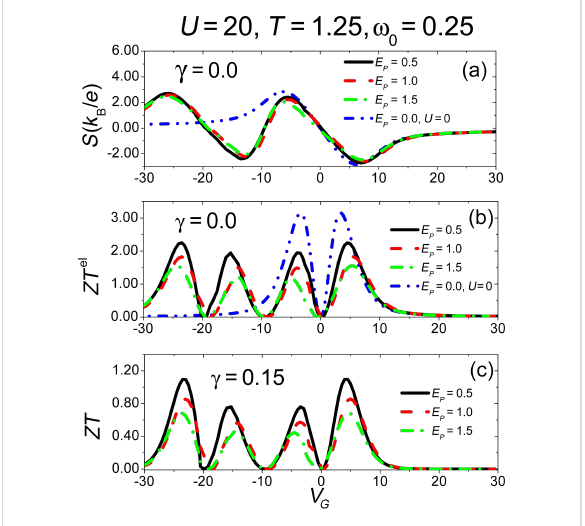
Figure 8: Thermal transport properties in the linear response regime, within the range of validity of the adiabatic approximation and includ- ing the electron–electron interaction. Panel (a): Seebeck coefficient S in units of k B / e for different values of electron–vibration coupling E P (in units of ). Panel (b): Dimensionless thermoelectric figure of merit ZT el for the electronic system only. Panel (c) shows the total thermo- electric figure of merit. Adapted and reproduced with permission from [82], copyright 2015 IOP Publishing. the electron–oscillator interaction are a reduction of the amplitude of the peaks, an increase of their broadening, and a shift their position towards negative energy.